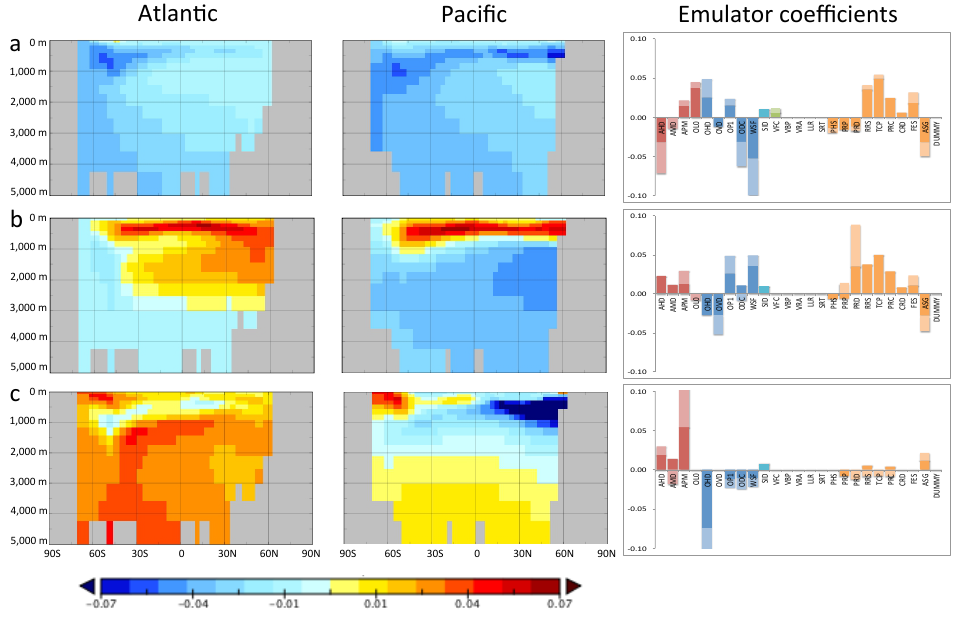
Fig. 9. Pre-industrial EOFs and PC emulator coefficients: (a) First EOF (42% of ensemble variance) (b) second EOF (27% of ensemble variance) and (c) third EOF (11% of ensemble variance). EOF magnitudes are in dimensionless units. Colour coding of the PC coefficients identifies the GENIE module to which the parameter relates: red – atmosphere; blue – ocean ; turquoise – sea ice; green – vegetation; orange – ocean biogeochemistry. Dark shaded bars are the coefficients from the emulation of the EFPC ensemble. Light shaded bars are the coefficients from the emulation of the Latin hypercube ensemble. Note the emulators are plotted as stacked columns, e.g. AHD coefficients in the first PC emulator are − 0.032 (EFPC) and − 0.039 (MLH).